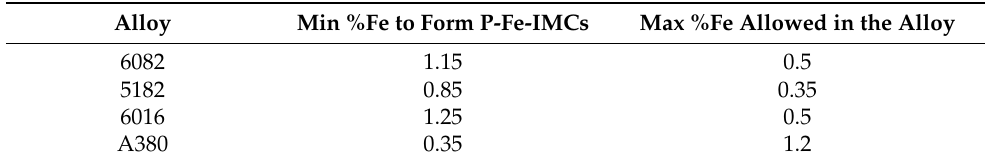
Table 1. Minimum level to form P-Fe-IMCs and commercial composition limits for the different alloys shown in Figure 1.